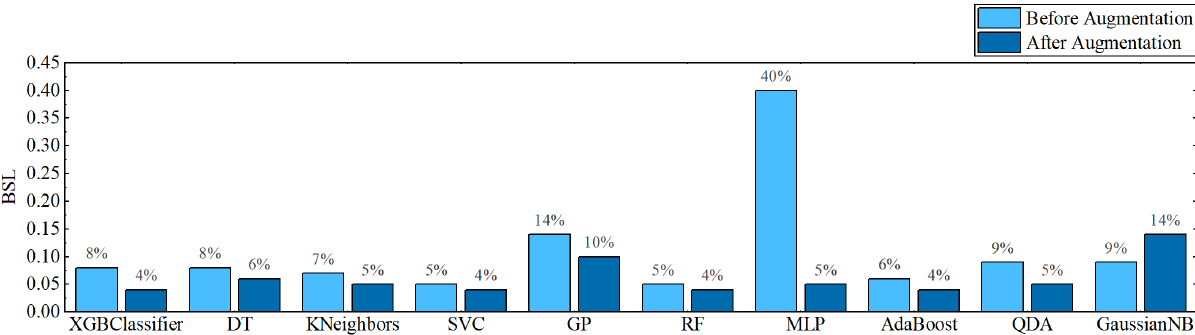
Figure 8. BSL results before and after data